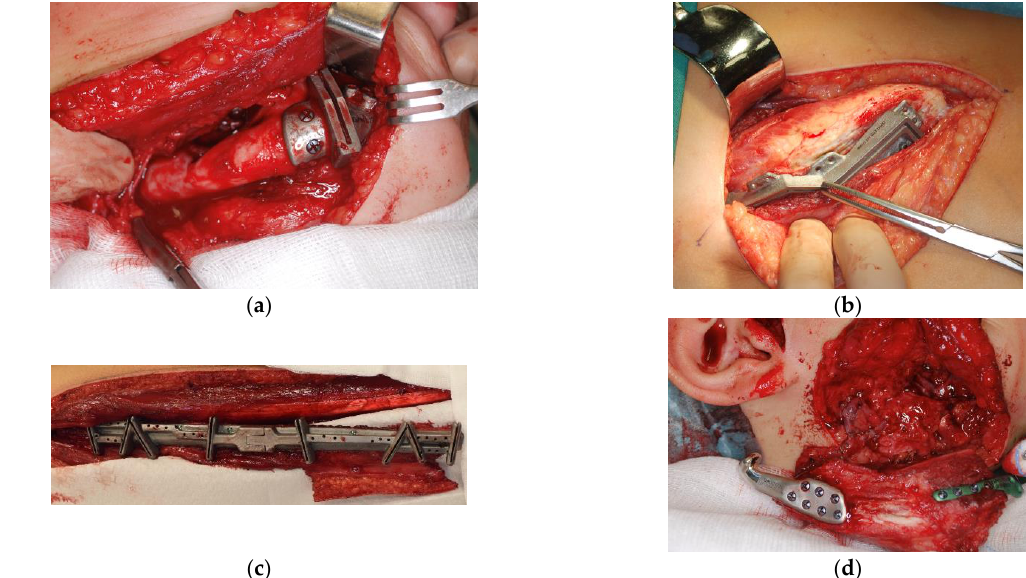
Figure 2. Intraoperative photographs showing examples of: ( a ) medial mandible resection template; ( b ) iliac graft harvesting template; ( c ) fibular graft harvesting template; and ( d ) intraoperative view of the graft (blue arrow) connected to the customized prosthesis and reconstruction plate (green) before fixing.